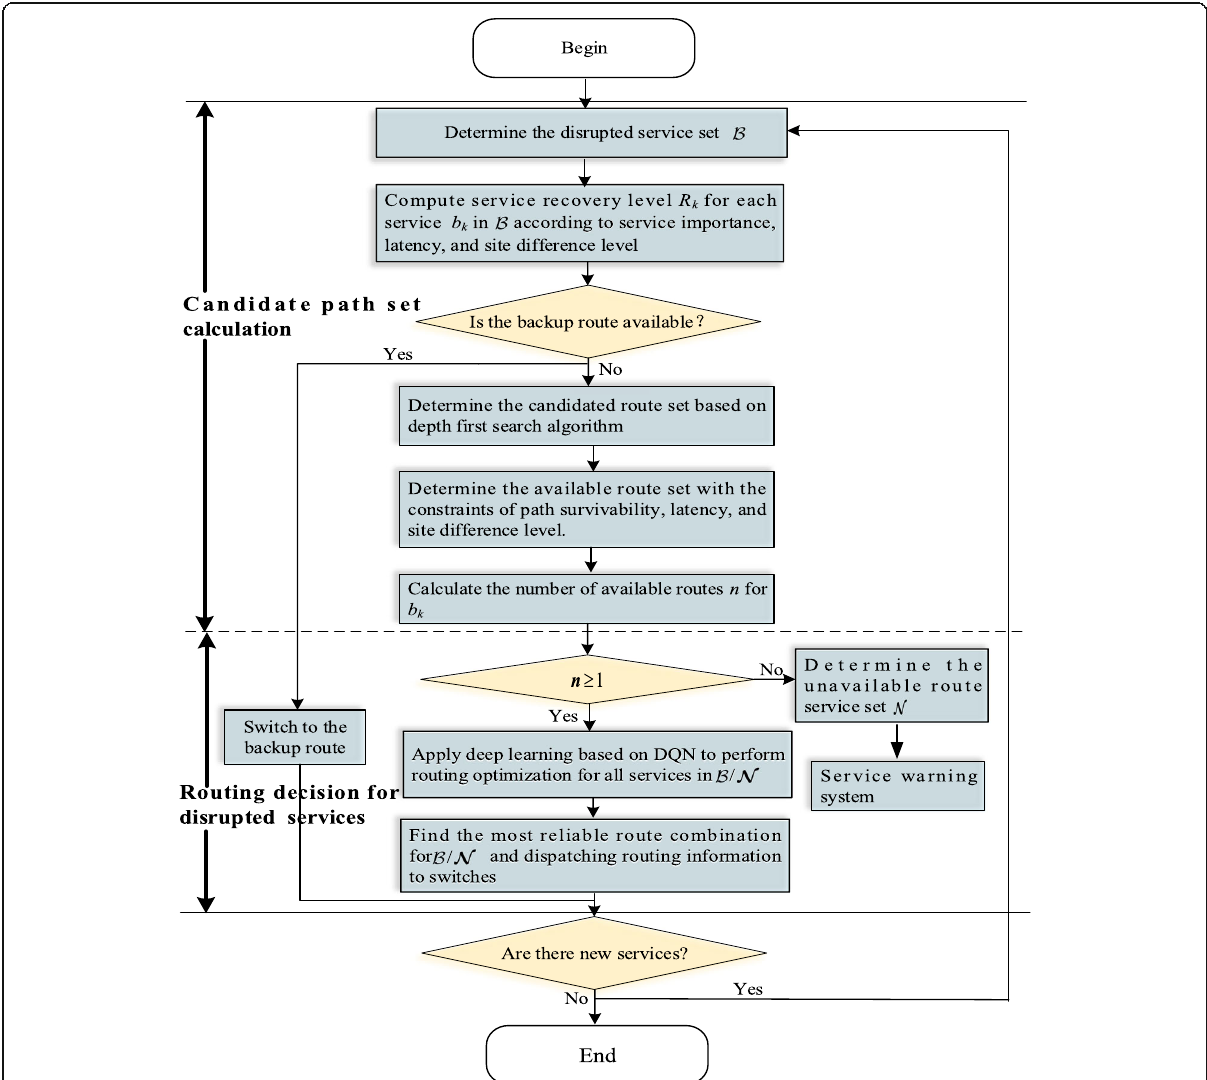
Fig. 2 Rerouting recovery mechanism in large-scale failures. This figure shows the rerouting process for services in SGCN. If the alternate path is available, the service can be switched to it; otherwise, the I-DQN algorithm combined with DFS is employed to find the optimal path combination for